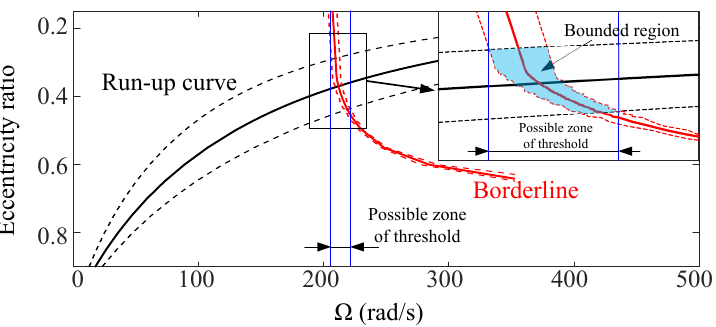
Figure 10. Mean values of run-up curve and borderline by gPC expansion and their 95% confidence intervals plotted with dashed lines as the